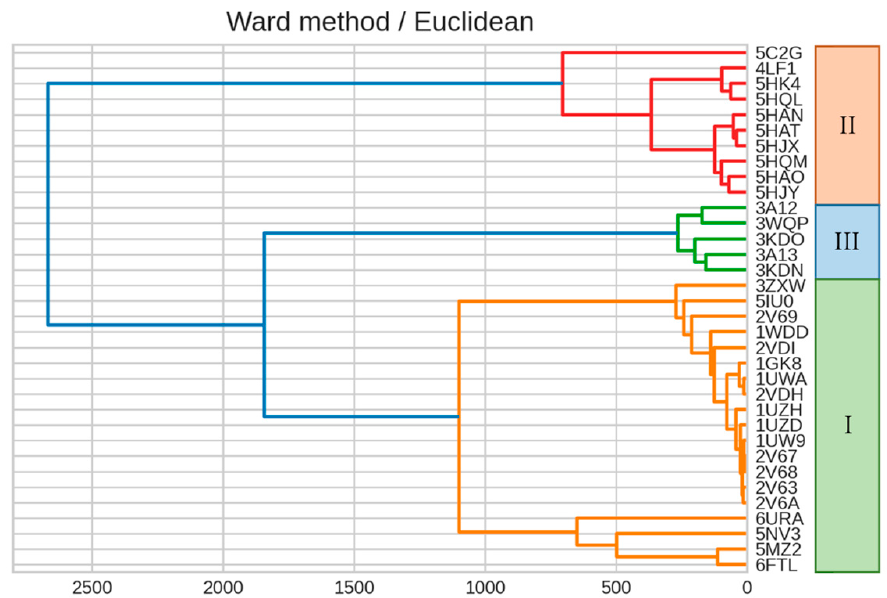
Figure 5. Dendrogram generated from the clustering result on IFIEs using Ward’s method. Color coding is set at 60% of the maximum Euclidean distance. The corresponding isoform specifications, I–III, identified by the sequence alignment (see Figure 4) are also shown.